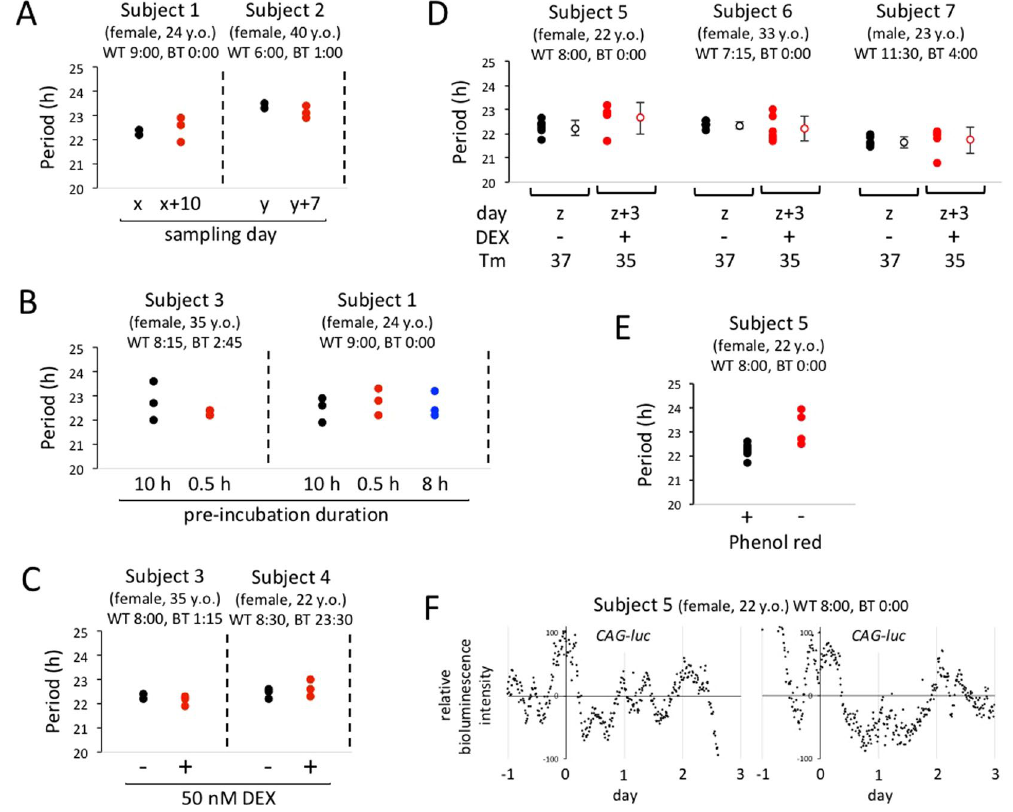
Figure 3. Validation of the ex vivo hairy root culture method. Hair roots obtained from healthy subjects were infected with an adenovirus vector carrying Per3-luc . WT and BT indicate wake-up time and bedtime, respectively. Bioluminescence was measured in real time with a photomultiplier tube. Data sets were detrended by subtracting the 24-h running average from the raw data, and the period length was calculated with a cosinor analysis. Oscillation data were considered reliable when both clear circadian oscillation persisted for ≥ 3 days and circadian robustness was 70% or more. The effect of difference in sampling day ( A ), the effect of difference in pre-incubation period ( B ), the effect of dexamethasone-induced synchronization of cellular clocks ( C ), the simultaneous effect of the difference in sampling day, measurement instrument, ambient temperature and DEX treatment ( D ), and the effect of the presence or absence of phenol red ( E ) were examined by comparing circadian period length between different conditions. To investigate reproducibility, two or three strands of hair were used for each experimental condition. ( F ) Hair roots were infected with a control adenovirus expressing the luciferase gene under regulation by the CAG promoter, a non-circadian promoter. Bioluminescence data sets were detrended by subtracting the 24-h running average from the raw